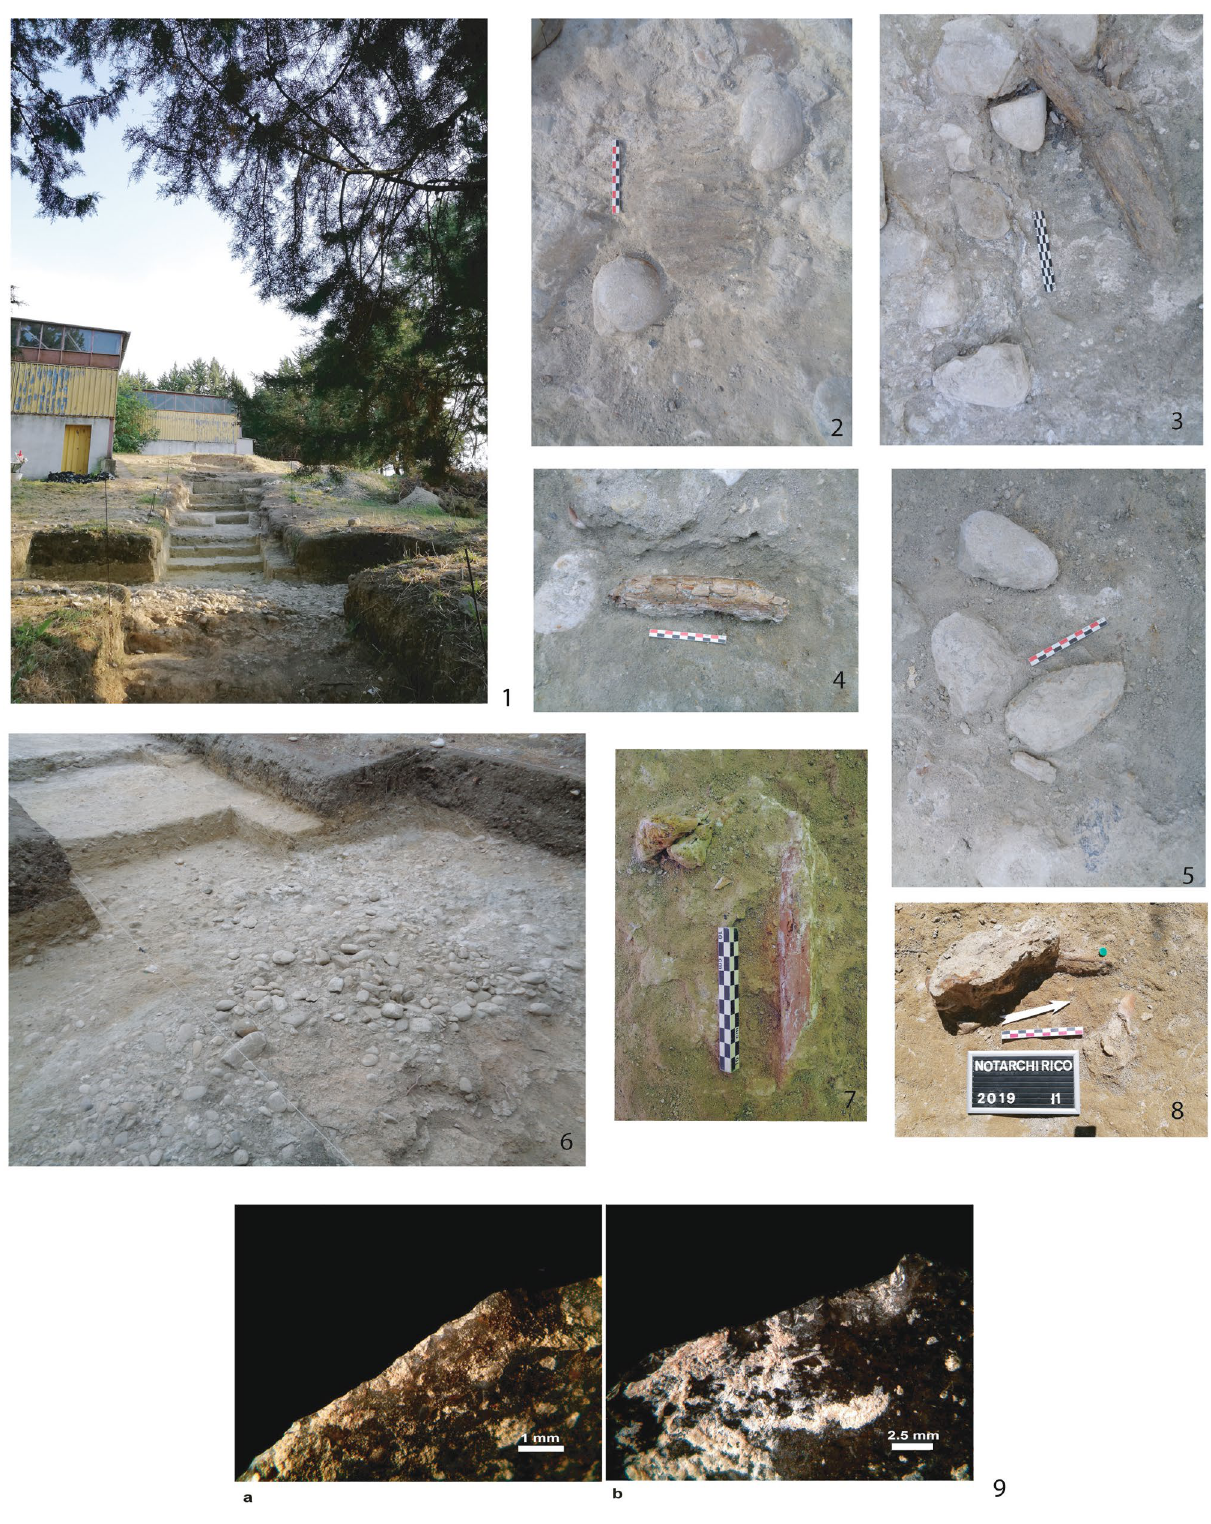
Figure 3. Illustrations of the new fieldwork at Notarchirico. ( 1 ) The 30 m-trench opened outside the building with the excavations of M. Piperno. ( 2 ) Layer F. Elephant tooth among the bed of pebbles. ( 3 ) Layer F. Fragment of elephant tusk and limestone pebble tools. ( 4 ) Layer G. Fragment of ungulate bone and pebble. ( 5 ) Layer F. Biface on a limestone pebble. ( 6 ) Aspect of layer I2, bed of pebbles. ( 7 ) Layer I2. Fragment of ungulate bone. ( 8 ) Layer I1. Fragment of bone. ( 9 ) (a) flake 2017 A18 F2: edge removals with feather/step terminations, diagonal unidirectional traces interpreted as resulting from cutting soft materials; (b) flake 2017 B19 F9: edge-removals with feather/step terminations, perpendicular direction interpreted as scraping soft/medium material. (Photos M-H. Moncel, C. Santagata n°1–8, n°9 C.